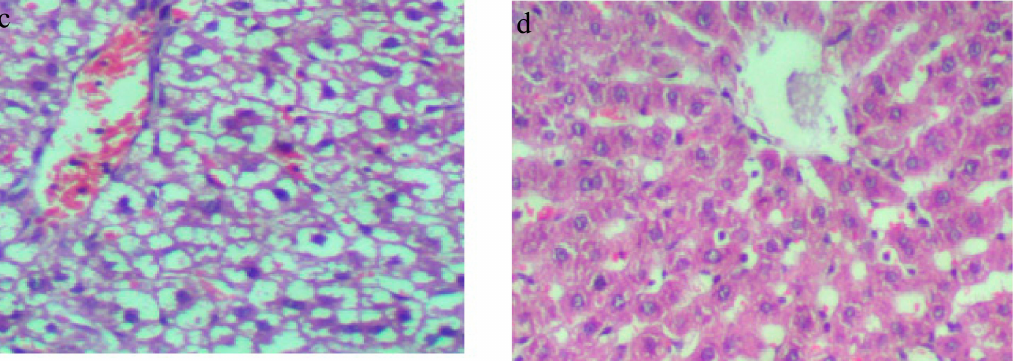
Figure 6. Tissue sections stained with hematoxylin and eosin (H&E; 400 × ) for the histological examination of the liver tissues of different groups in comparison to the control group ( a ) Gp I: normal control, ( b ) Gp II, ( c ) Gp III: (silymarin 50 mg/kg), ( d ) Gp IV: (MESC 200